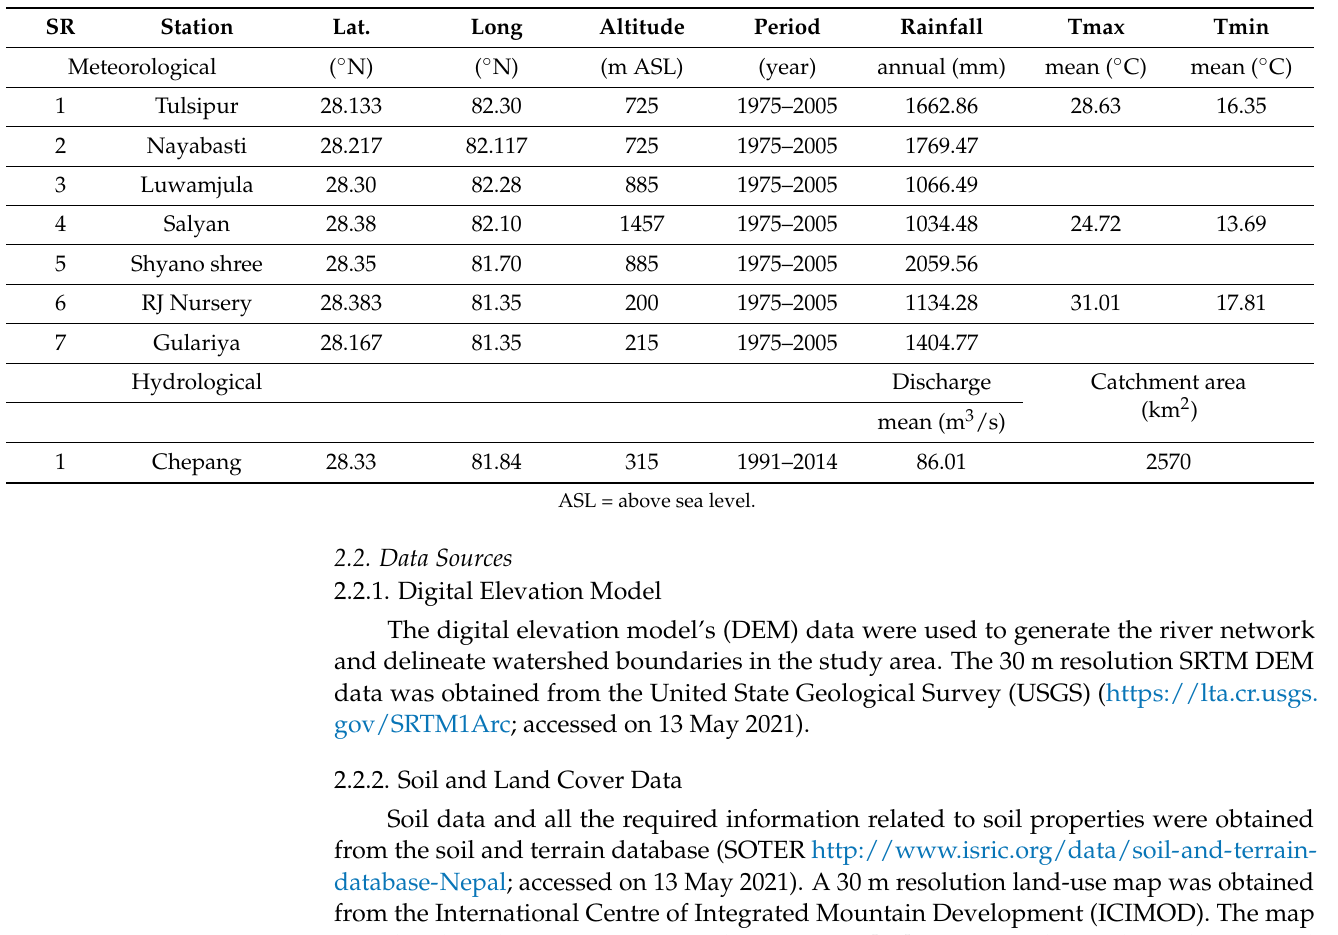
Table 1. Basic information about the hydro-climatic stations in the Babai River